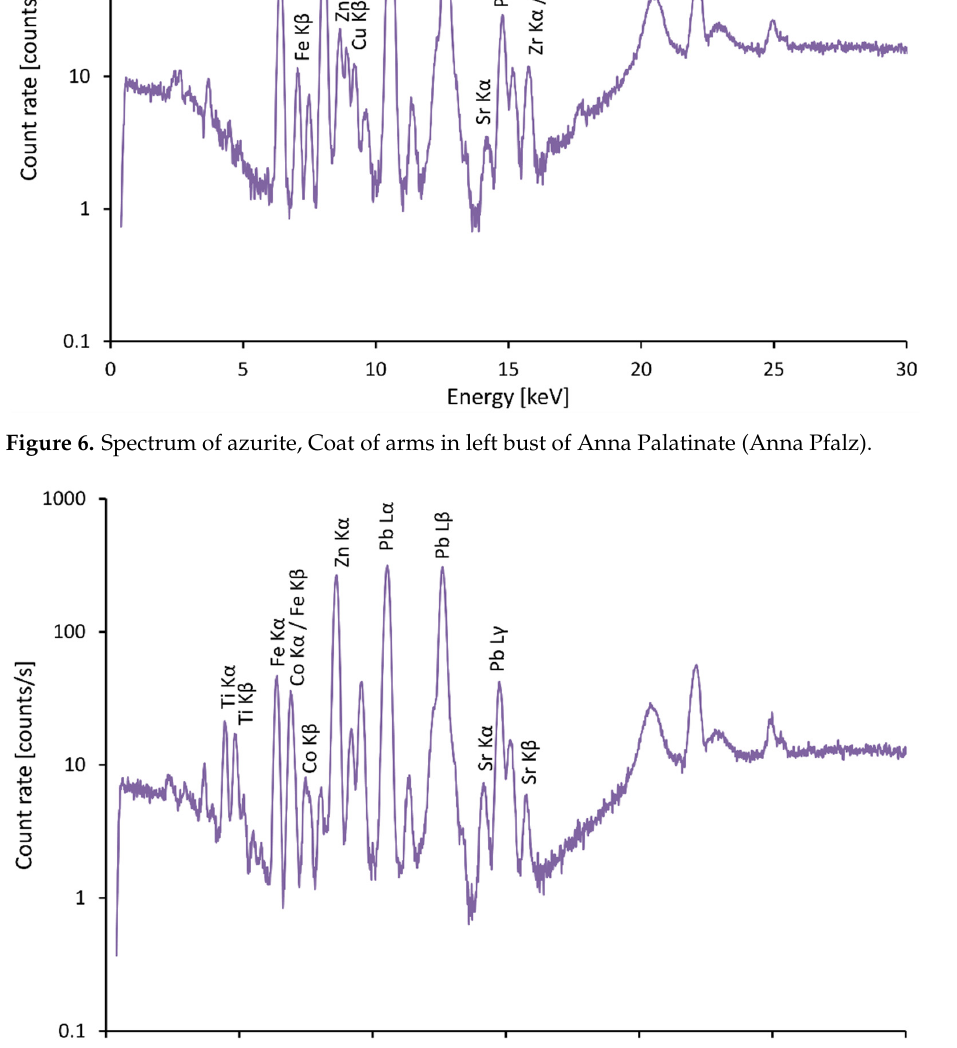
Figure 7. Presence of cobalt blue in blue color, retouched